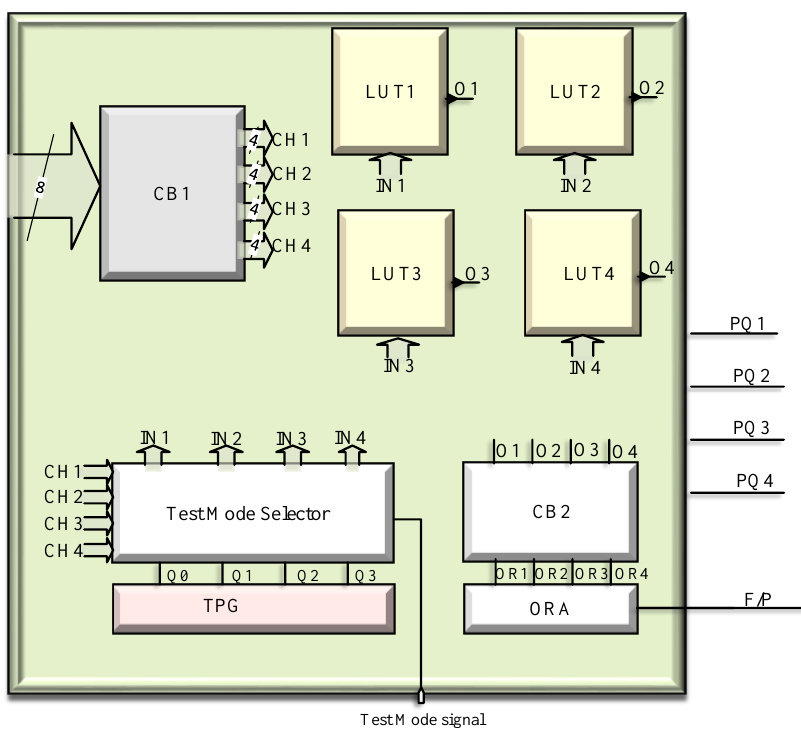
Figure 6. CLB architecture including BIST core.